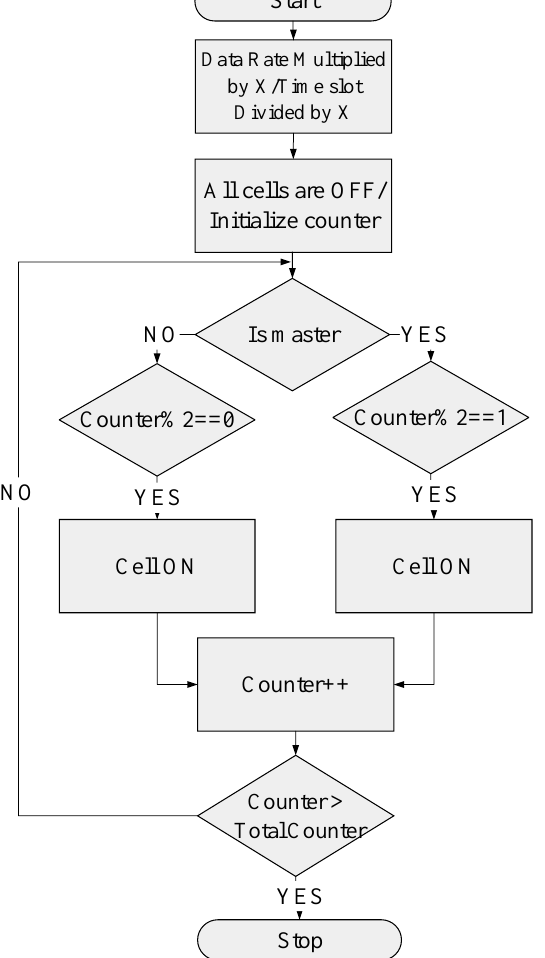
Figure 7. Flow graph of the Sleep/Wake-up mode